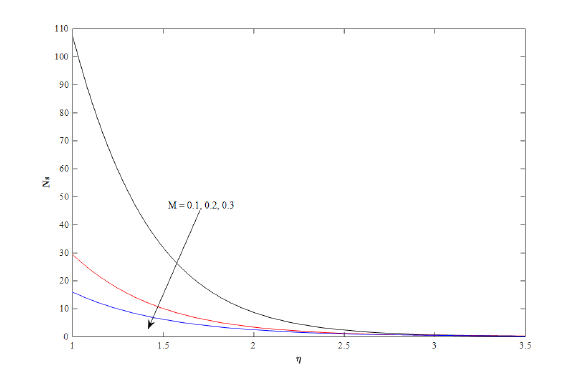
Fig. 2 Entropy generation number with varying M when Br = 1 , S = 0 . 01 , Q = 1 , X = 2 , Pr = 2 , ω = 1 , K = 0 . 95 .